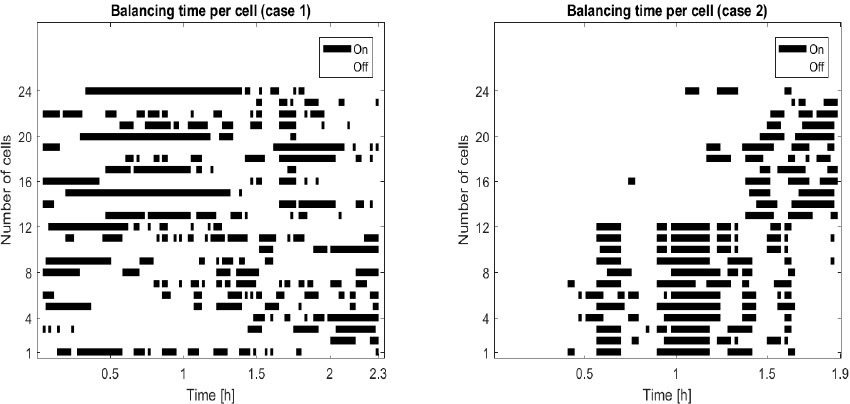
Figure 21. Balancing time per cell during charging.